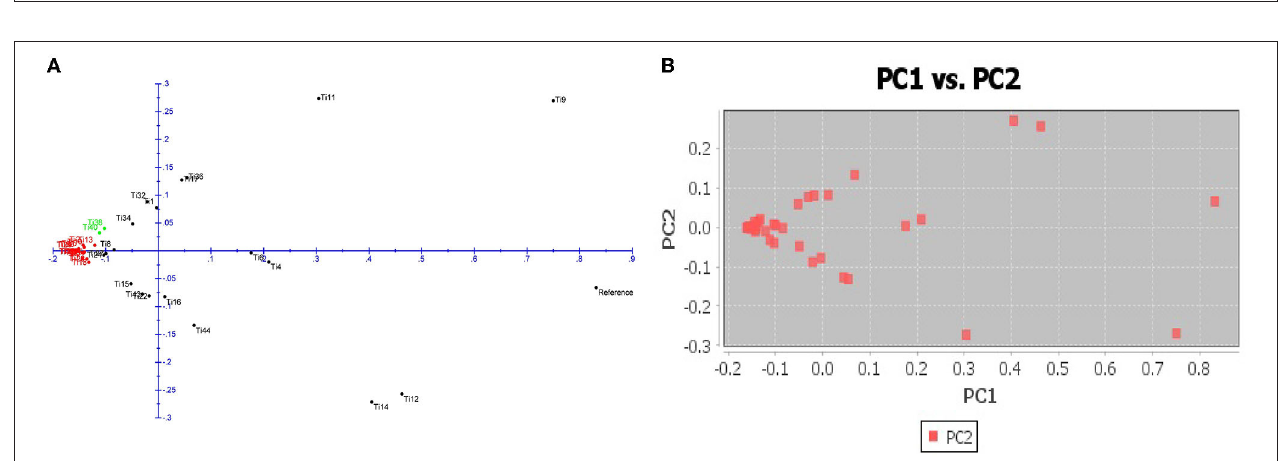
FIGURE 8 | Biplot showing the relationship among T. indica isolates in terms of principal components analysis (PCA). Axis-x and axis-y refer to the first and second principal components, which explained 50.32% and 9.91% of the total variation, respectively.